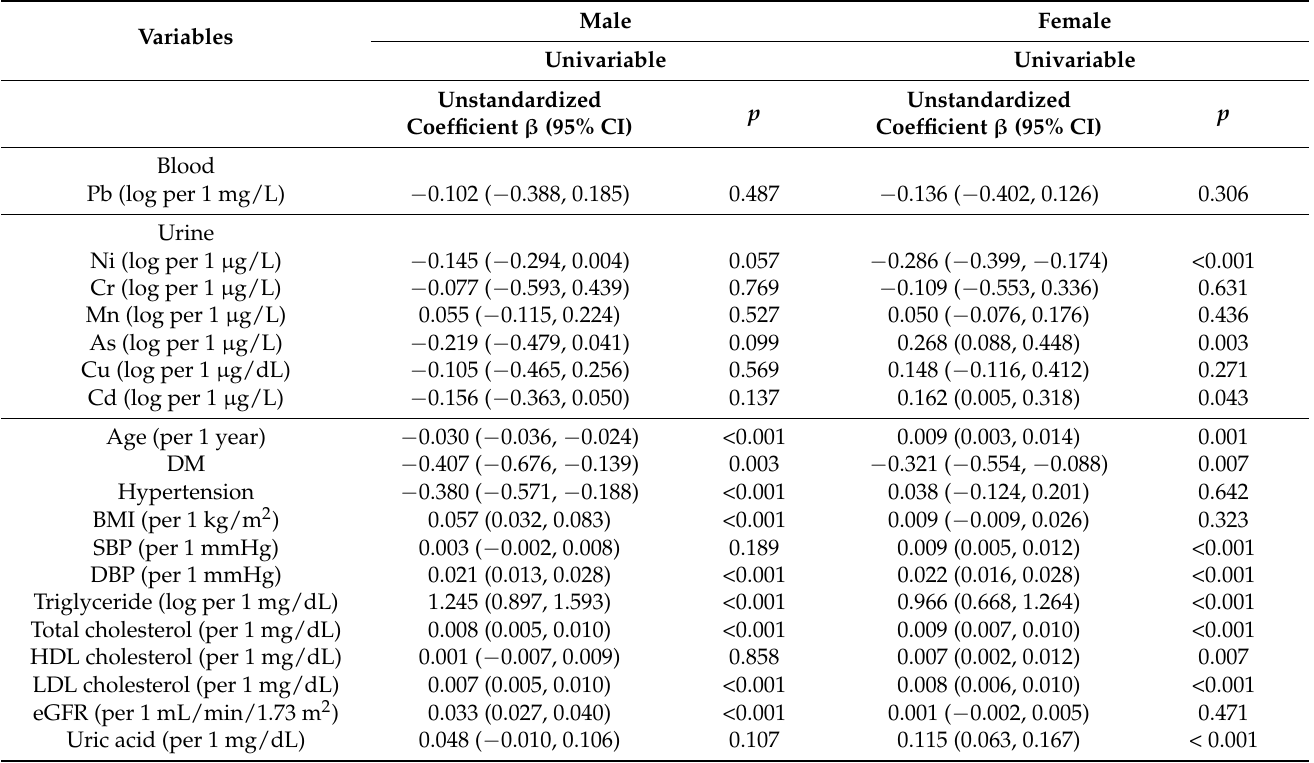
Table 2. Association of heavy metals and variables with Hgb using univariable linear regression analysis by gender.